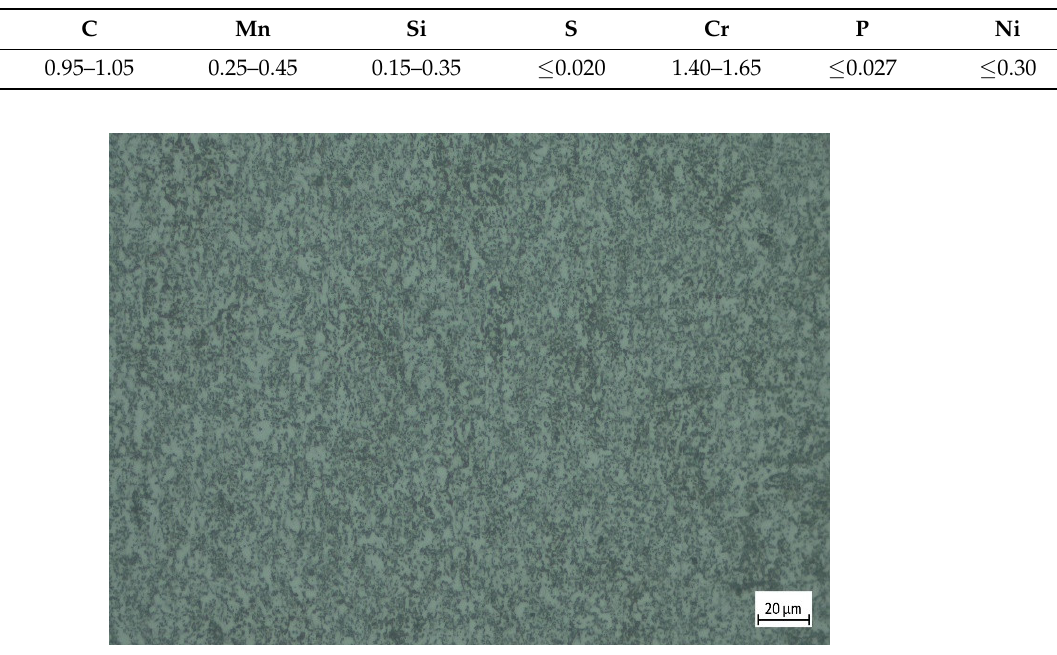
Figure 1. Microstructure of normalized GCr15 steel.